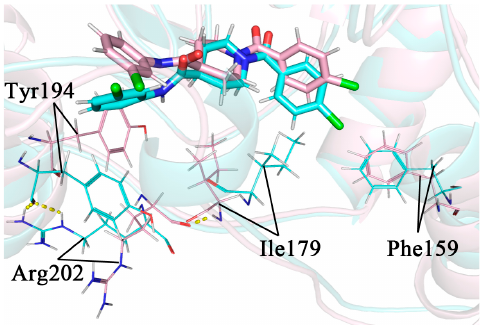
Figure 13. Comparison images of the superimposed snapshots of 32 ns (pink) and 34 ns (blue) in complex 4, with the flipped key residue shown in line mode and the hydrogen bond shown in yellow dashed mode. The inhibitor tail is shown on the left and the inhibitor head is shown on the right in the figure.